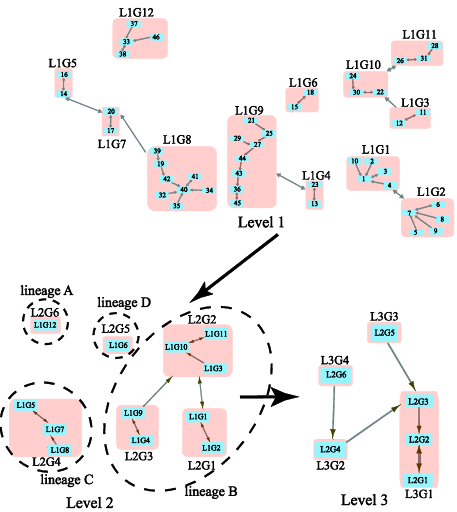
Figure 2. Multi-level clustering of the beta coronavirus network by MSClustering.